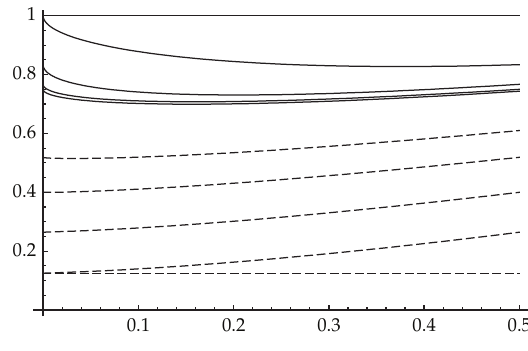
Figure 2: w 4 (cid:6) 0 (cid:7) ≈ 0 . 75 and w 4 (cid:6) 0 . 5 (cid:7) ≈ 0 .